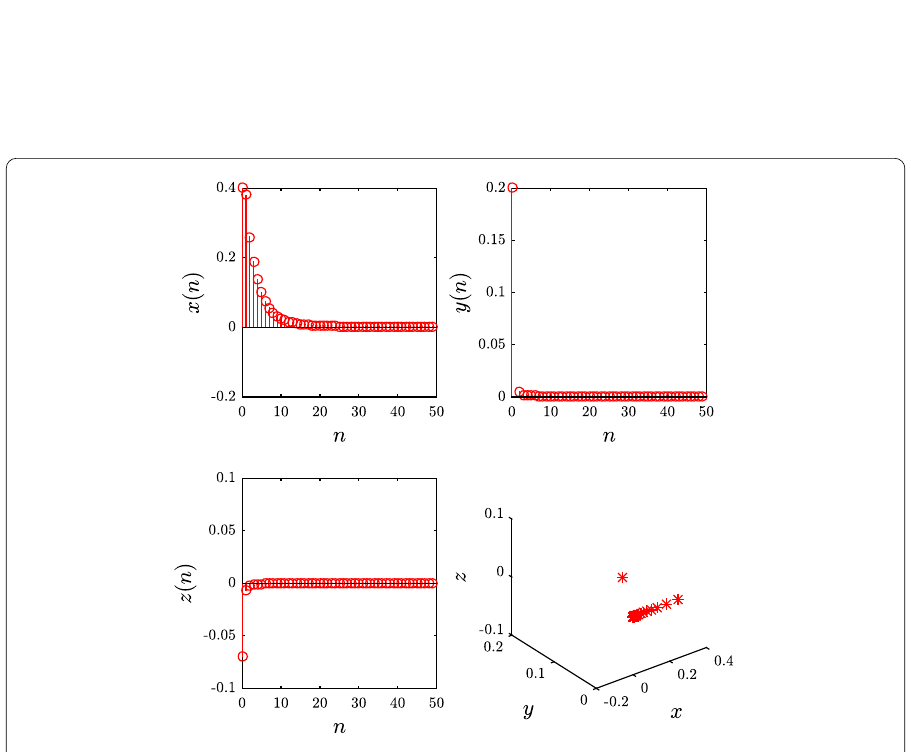
Figure 21 The time evolution of the controlled states for the fractional Wang